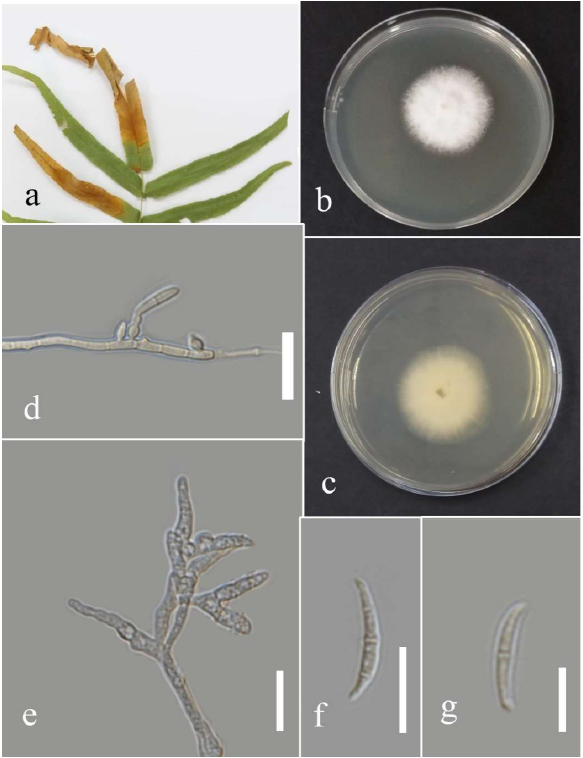
Figure 34. Morphology of Fusarium ipomoeae based on the isolate MFLUCC 22-0143: ( a ) leaf blight on Pteris grandifolia ; ( b , c ) upper and reverse views of the colony after seven days of growth on PDA at 28 ◦ C; ( d ) conidiogenous cells; ( e ) phialides; ( f , g ) mesoconidia. Scale bars ( d – f ) = 20 µ m and ( g ) = 10 µ